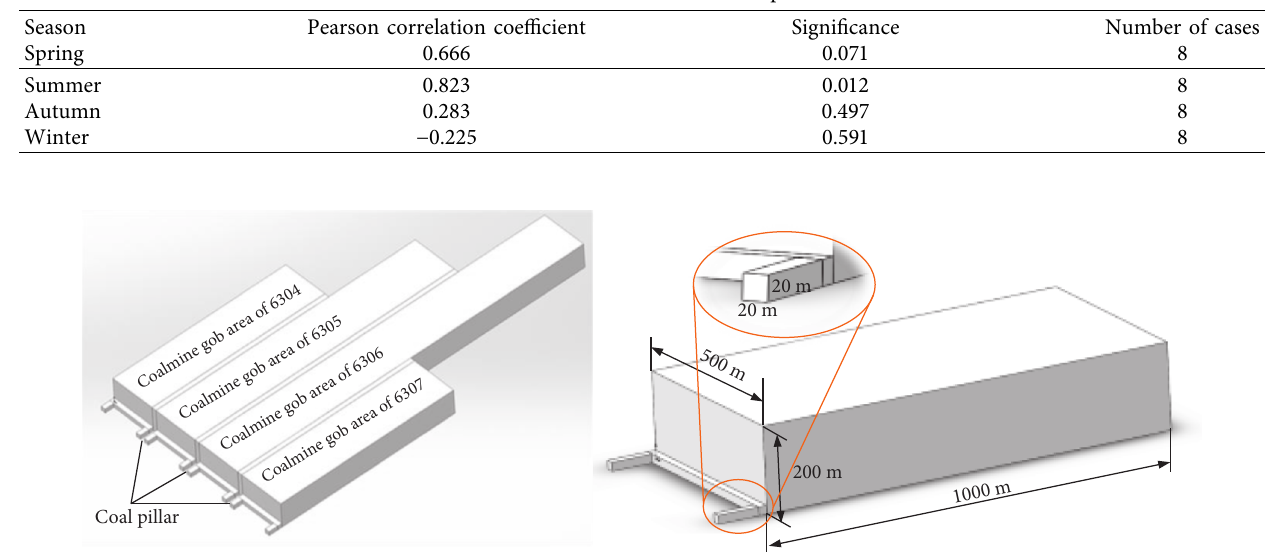
Figure 8: Deep mine model established through solidworks.